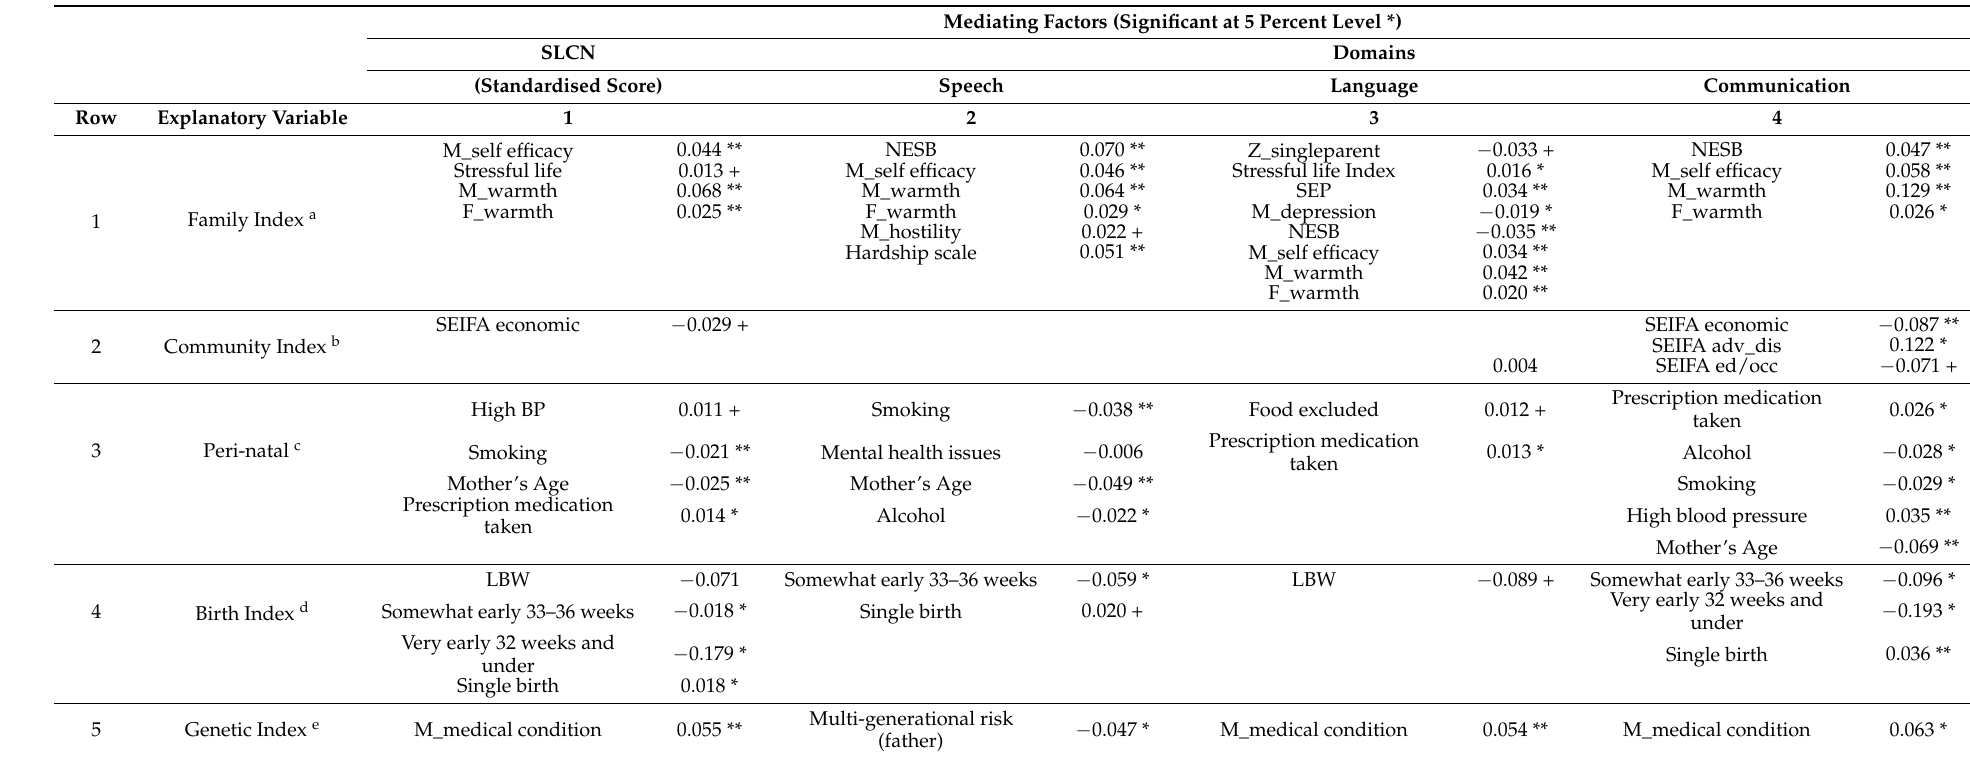
Table 3. Mediating factors of